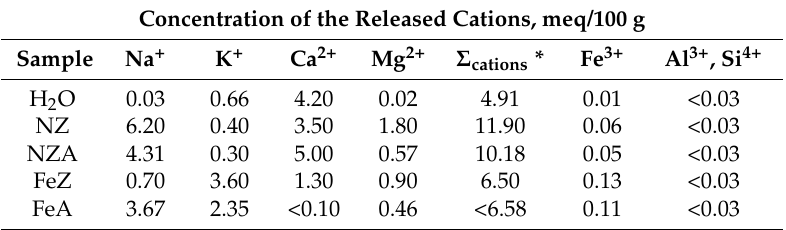
Table 5. Concentrations of the released cations from adsorbents after contact with water.